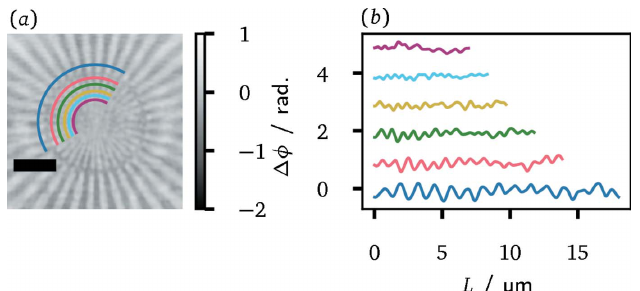
Figure 10 Illustration for the determination of the resolution estimates (cid:2) r h and (cid:2) r v at the example of grating interferometry in the Talbot order m T = 11/16. The scale bar in the reconstruction ( a ) indicates 5 m m length. Panel ( b ) shows multiple section profiles along the circular segments marked in ( a ). The section profiles are offset with respect to each other and the length L of the line segments, that the phase shift values are plotted over, is measured anti-clockwise.